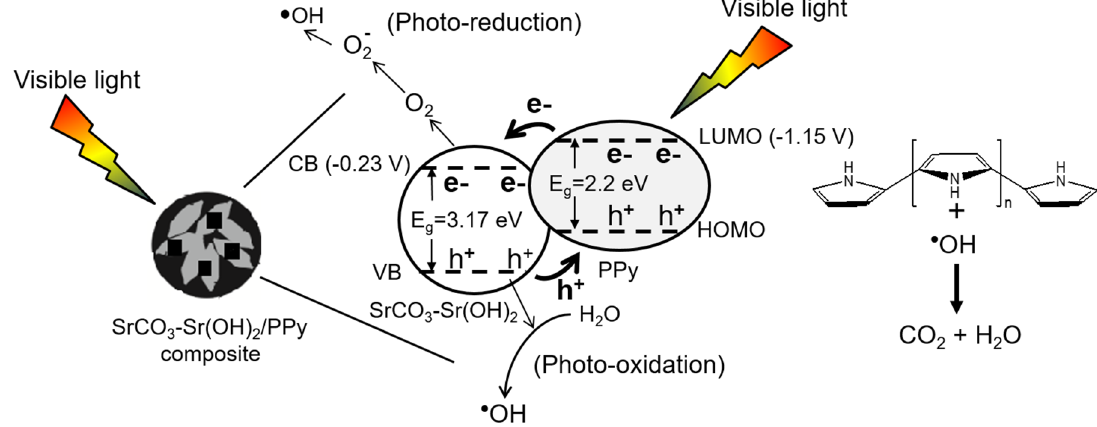
Figure 9. Possible MB dye photodegradation process.